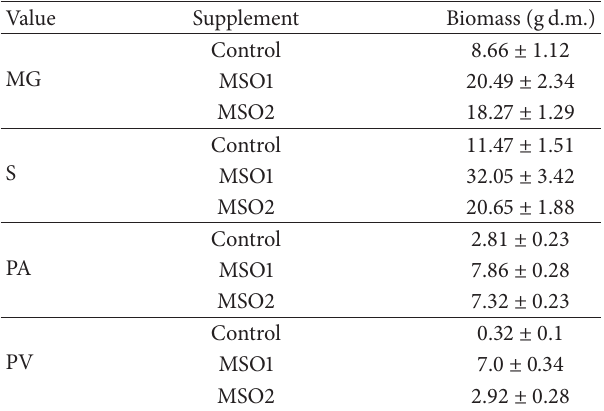
Table 2: The biomass of Miscanthus giganthus , Salix spp., Phalaris arundinacea , and Pancium virgatum calculated as an average value of gram dry matter per